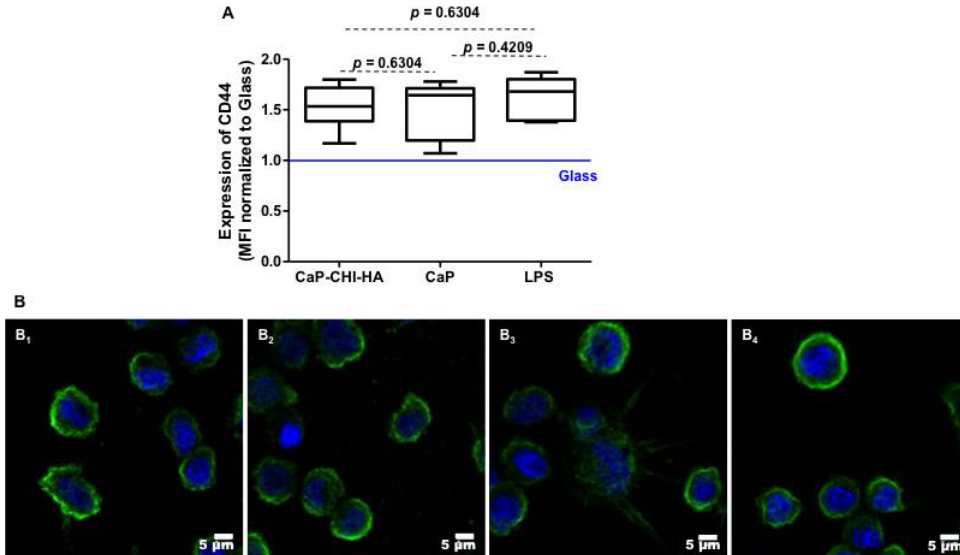
Figure 4. CD44 expression. Median fluorescence intensity normalized to glass, obtained by flow cytometry ( n = 6, Mann Whitney statistical test) ( A ) and confocal laser scanning microscopy views of CD44 labelled receptors ( B ) expressed by THP-1 in contact with CaP-CHI-HA ( B 1 ), CaP ( B 2 ); stimulated with LPS ( B 3 ) and on glass ( B 4 ) showing clustered and functional receptors at the membrane whatever the studied condition. Green color corresponds to CD44 and blue to nuclei (scale bars indicate 5 μm).